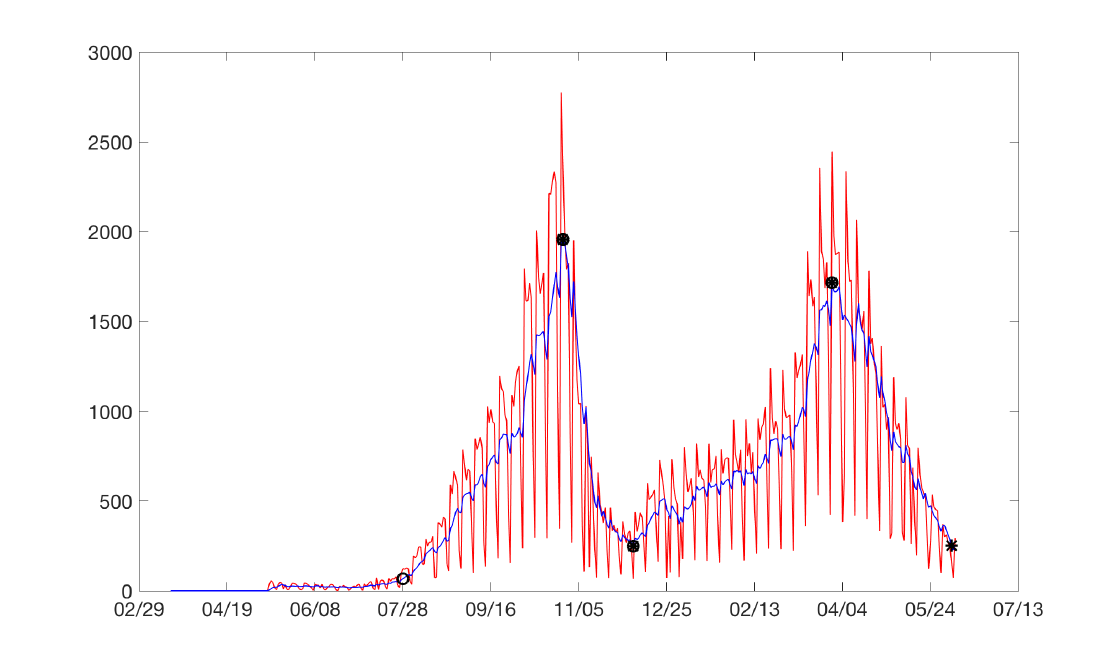
Figure A23. Paris: on the horizontal axis is the date in days and on the vertical axis are the daily